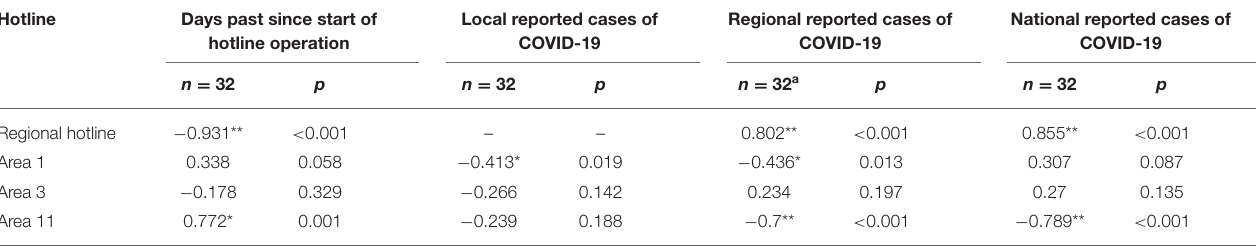
TABLE 3 | Correlations between numbers of calls received at selected hotlines and number of days past since their operation, daily confirmed COVID-19 cases in the sub-regional local area, in the region, and in the country.